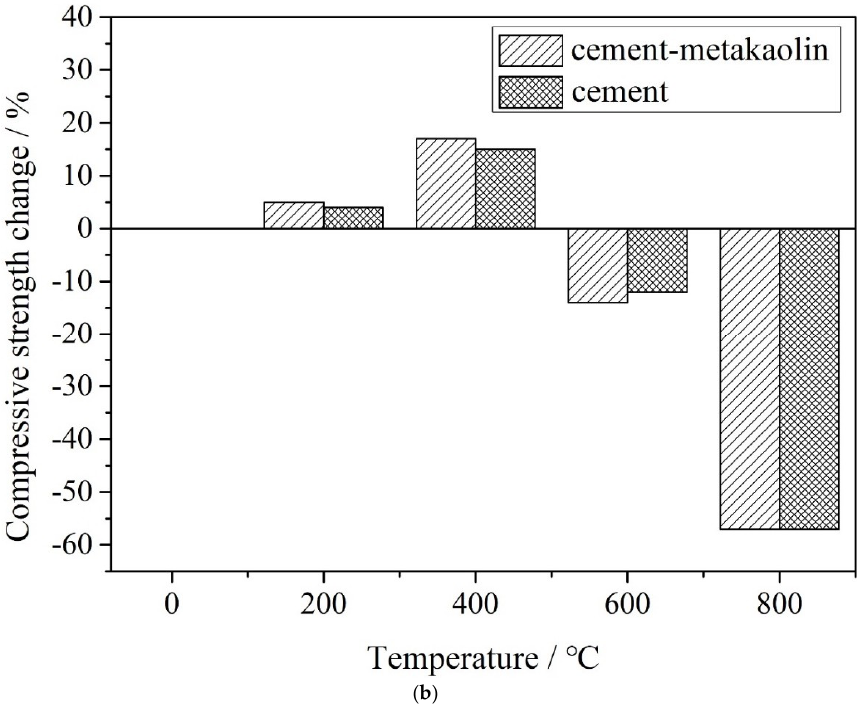
Figure 3. Effect of metakaolin on compressive strength of cement paste at different temperatures. ( a ) Compressive strength; ( b ) compressive strength change rate.